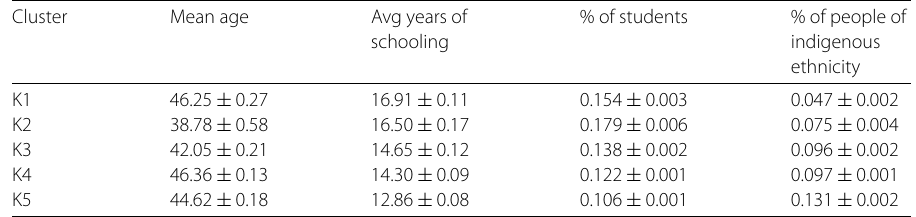
Table 3 Insights of the clusters. In these table are shown the mean values of the features for each cluster Cluster Mean age Avg years of